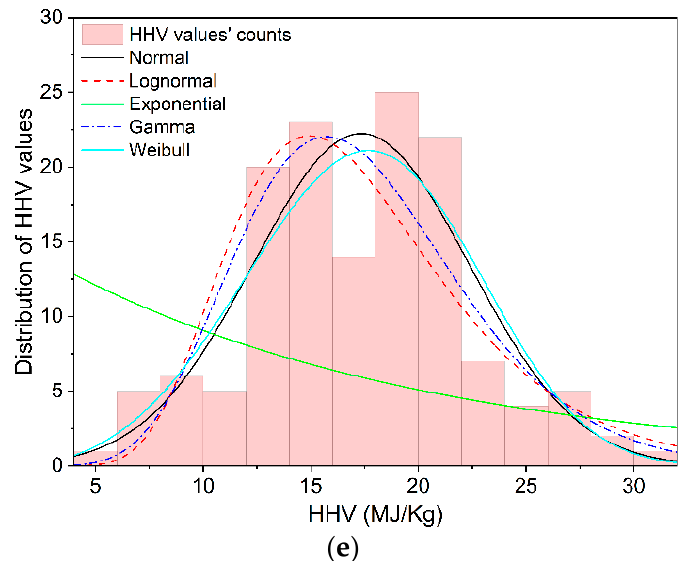
Figure 3. Plots of the distributions of the C ( a ), H ( b ), O ( c ), T ( d ), and HHV ( e ) values. The original data (bar diagrams) and the corresponding normal (black solid line), lognormal (red dashed line), exponential (green solid line), Gamma (blue dash-dotted line), and Weibull (light blue solid line) approximating distributions of their values are depicted in each case.